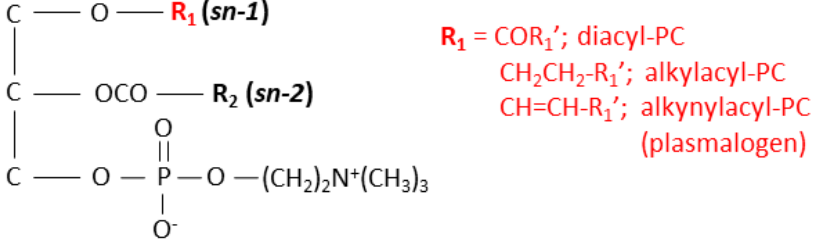
Figure 1. Structures of diacyl-, alkylacyl-, and alkenylacyl-phosphatidylcholine (PC) species.